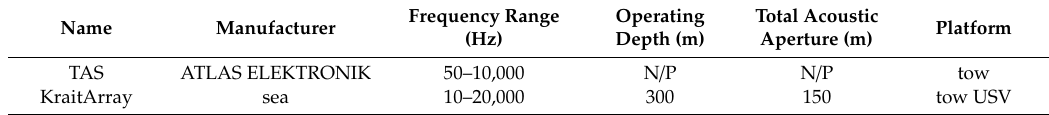
Table 13. Acoustic sensor: passive sonars—towed array sonar